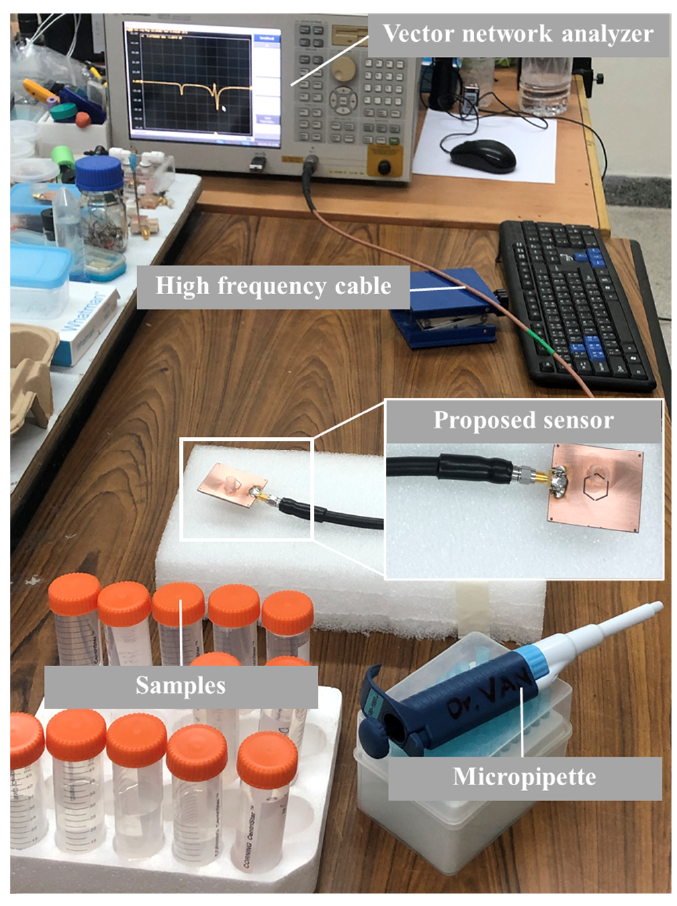
Figure 3. Measurement setup.